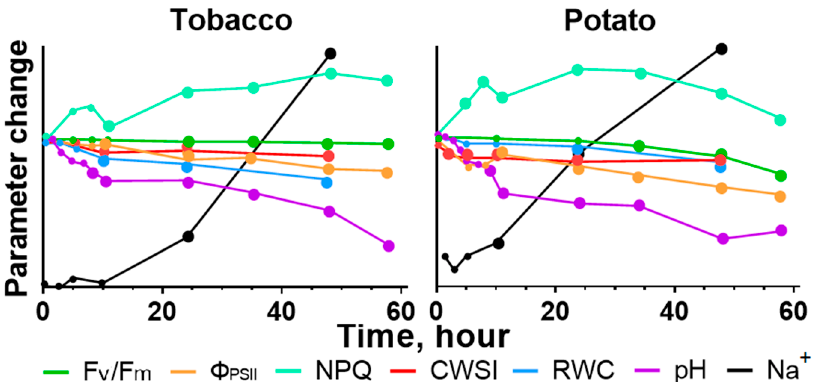
Figure 8. Common temporal dynamics of early (among leaves of different stratum) changes for all measured parameters for tobacco and potato plants. Small dots indicate experimental points, large dots indicate transition to significant changes of parameter relative to control condition.